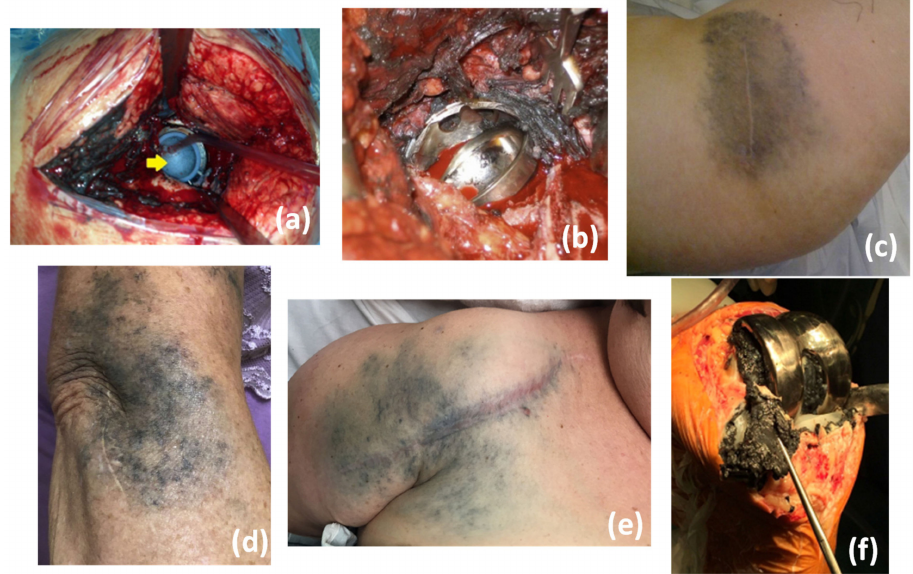
Figure 5. Metallosis in hip prosthesis with MoP ( a ) [36] and MoM ( b ) [37] implants; cutaneous manifestation of metallosis in the hip ( c ) [37], elbow ( d ) [38], shoulder ( e ) [29], and knee ( f ) [39] implants. Reproduced with permission from [29] Copyright 2018, Elsevier; [36] Copyright 2015, Elsevier; [37] Copyright 2012, Elsevier; [38] Copyright 2022, Elsevier; [39] Copyright 2020,